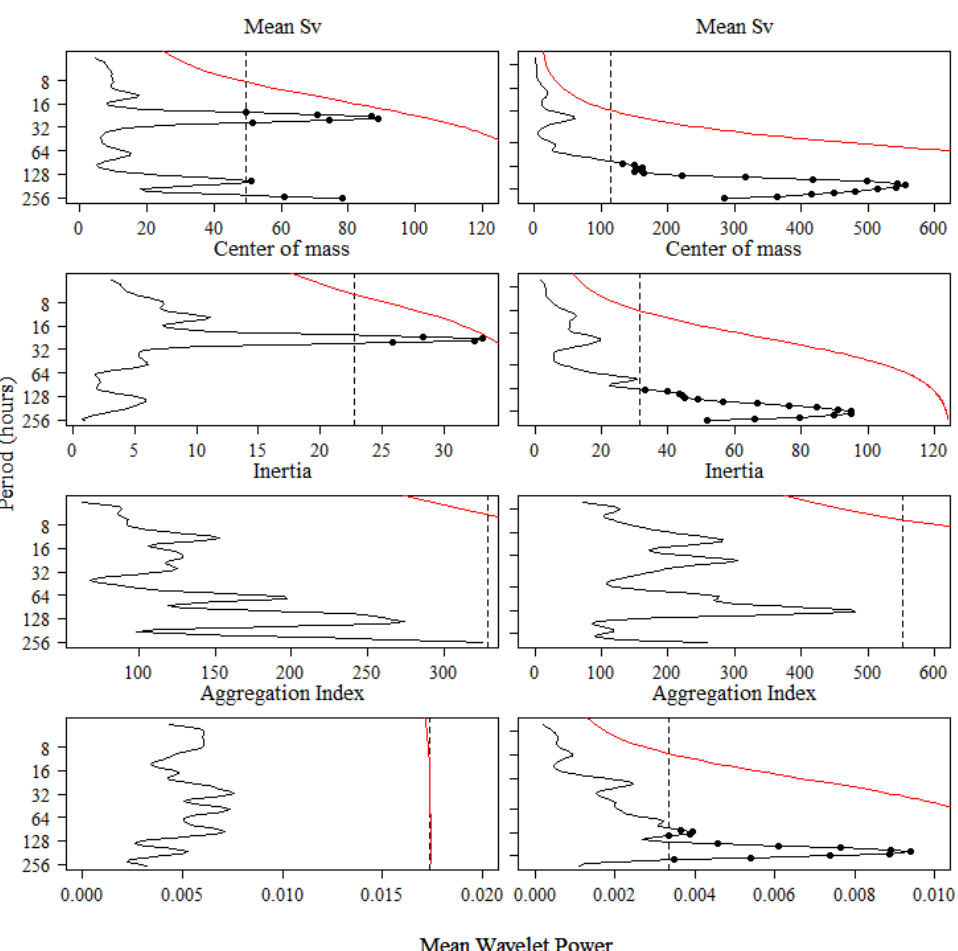
Fig. 4. Time averaged variance (global wavelet spectrum) of biological descriptors at the Admiralty Inlet (WA) tidal site (left panel) and the PacWave Energy Test Site (OR) wave energy site (right panel). Dashed black line represents white noise and the red solid line represents red